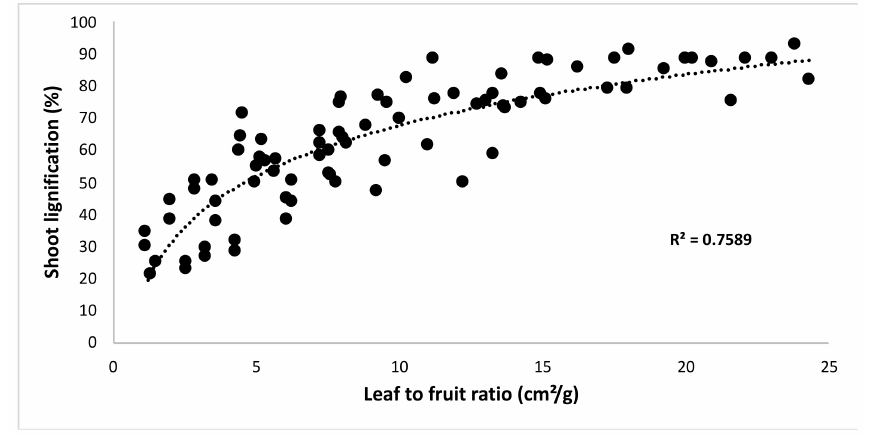
Figure 2. E ff ects of the leaf-to-fruit ratios (cm 2 / g) on the percentage of shoot lignification in cv. “Sauvignon